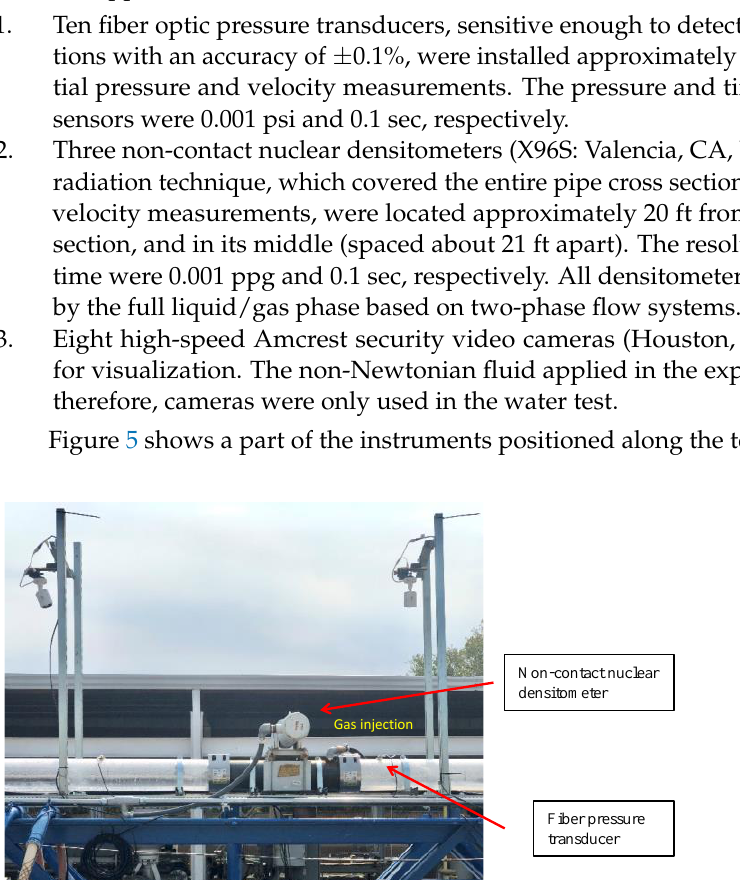
Figure 5. Instruments positioned along the test section.